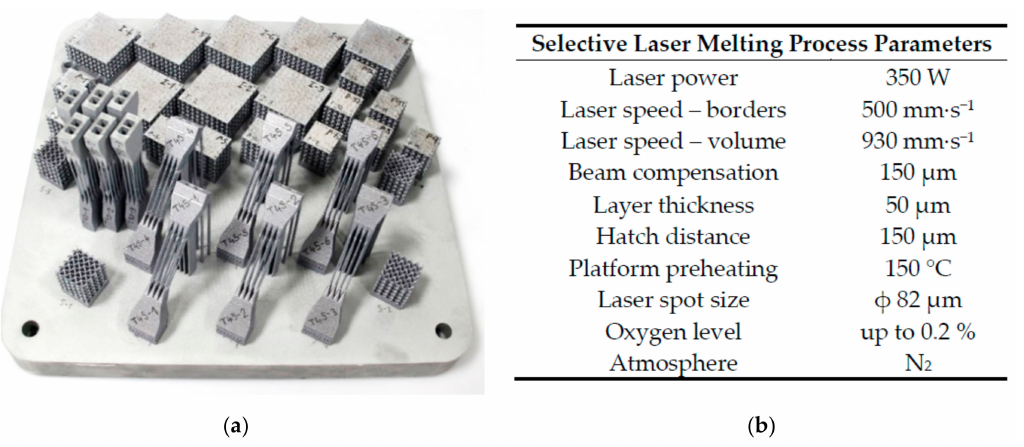
Figure 1. ( a ) Single series of mechanical specimens after SLM manufacturing; ( b ) SLM laser process parameters used for specimen